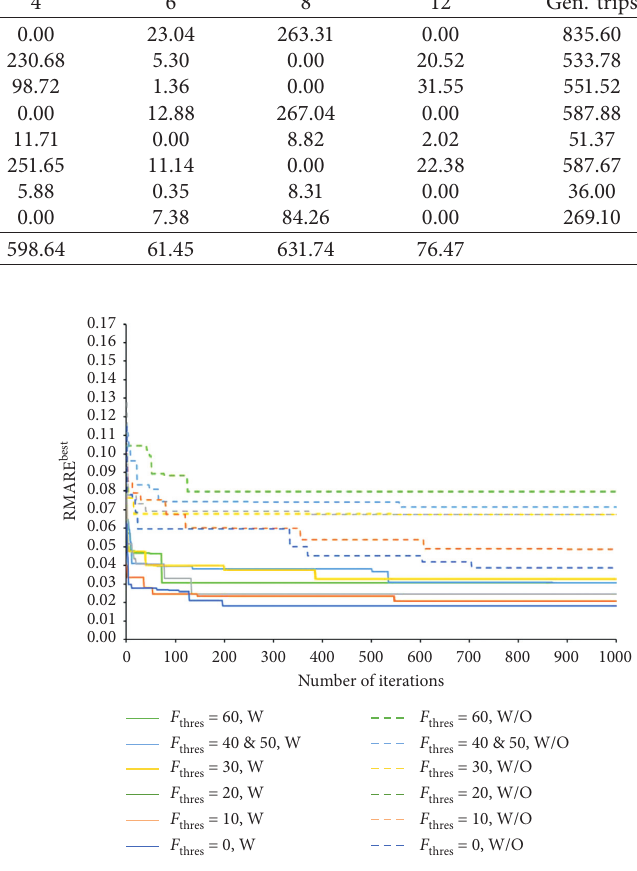
with (W) or thres